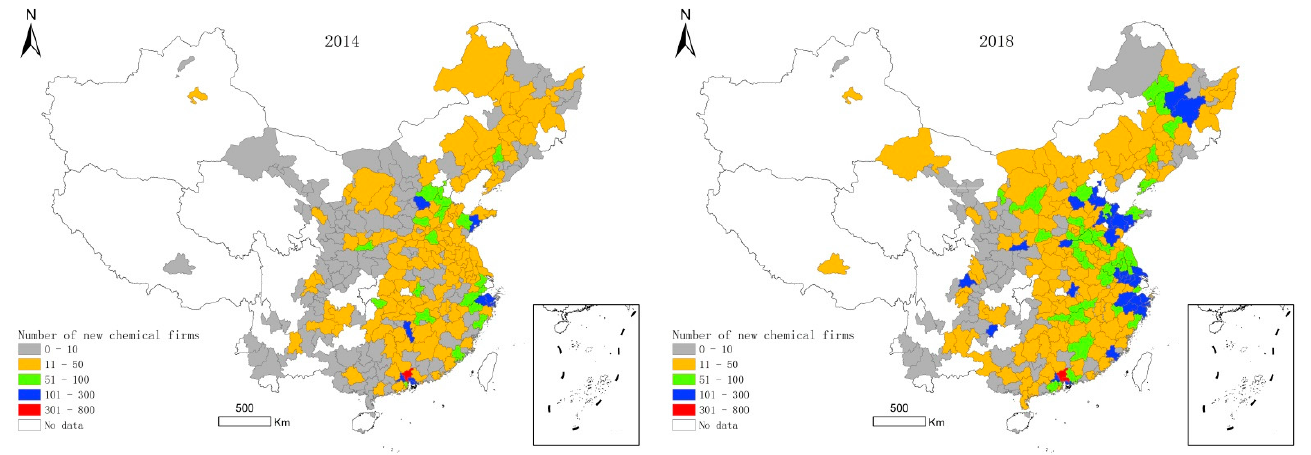
Figure 2. Location dynamics of new chemical firms in prefecture-level cities in China.